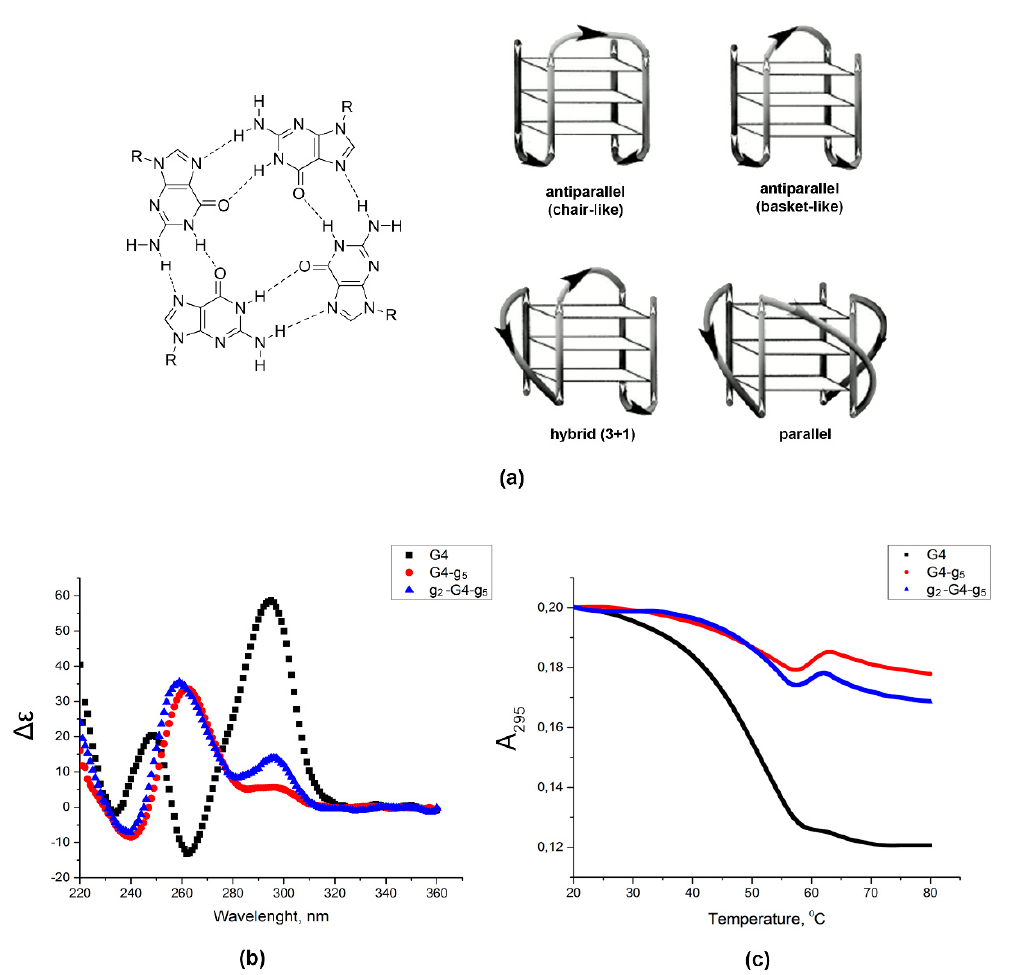
Figure 7. Structural features and thermal stability of G-quadruplexes used in this work. ( a ) Schematic representation of folding topologies of intramolecular G-quadruplexes adapted by ODNs with human telomere repeats. ( b ) CD spectra of ODNs with four telomere repeats including those containing terminal phosphorothioate oligoguanosines in buffer A at 30 °C. ( c ) Melting profiles of ODNs G4, G4-g 5 , and g 2 -G4-g 5 ; temperature dependence of UV absorption was registered at 295 nm in buffer A.